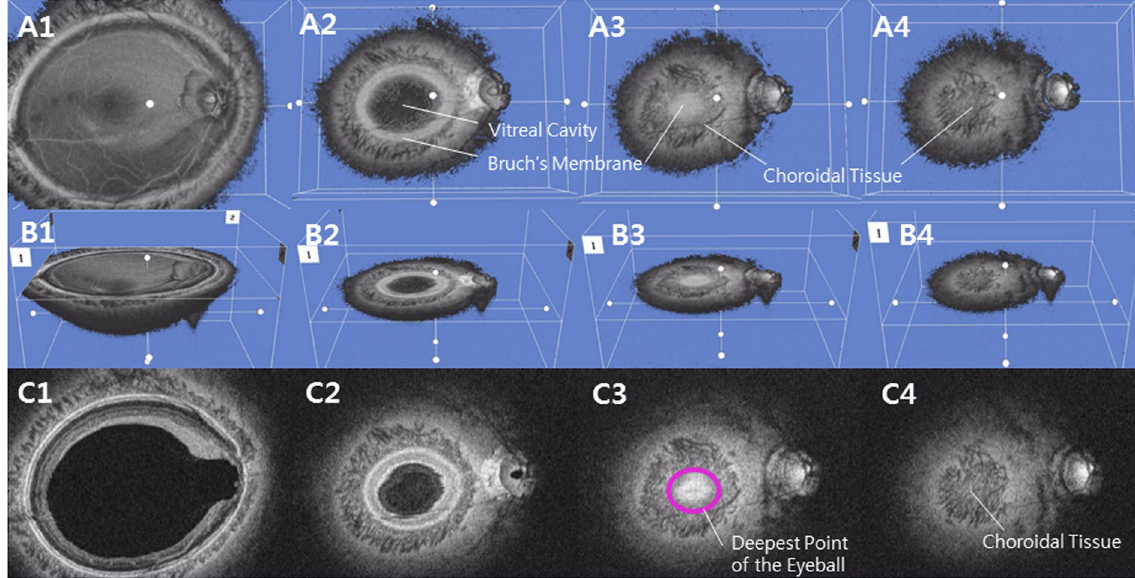
Figure 1. Schematic presentation of the three dimensional assessment of the posterior globe. ( A ) Coronal section image of the three dimensional reconstruction of the posterior globe. The number increases as the section of the posterior pole proceeds posteriorly. A2 represents shape of a posterior pole with vitreal cavity in the center surrounded by hyper-reflective Bruch’s membrane. A3 represents the interface of the Bruch’s membrane that is surrounded by the hypo-reflective choroid. Choroidal tissue appears when the section proceeds the Bruch’s membrane (A4). ( B ) Coronal section image of the three dimensional reconstruction of the posterior globe seen diagonally. The number indicates the identical section as the coronal section in A1 through A4. ( C ) Coronal section image of the three dimensional reconstruction of the posterior globe seen in En face view. The number indicates the identical section as the coronal section in A1 through A4. Deepest point of the eyeball is indicated in a purple circle in